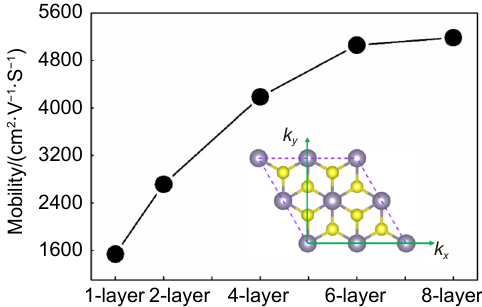
Fig. 6 | The DFT calculated deformation potential limited elec- tron mobility along k x direction of SnS 2 vs. the number of SnS 2 layers.